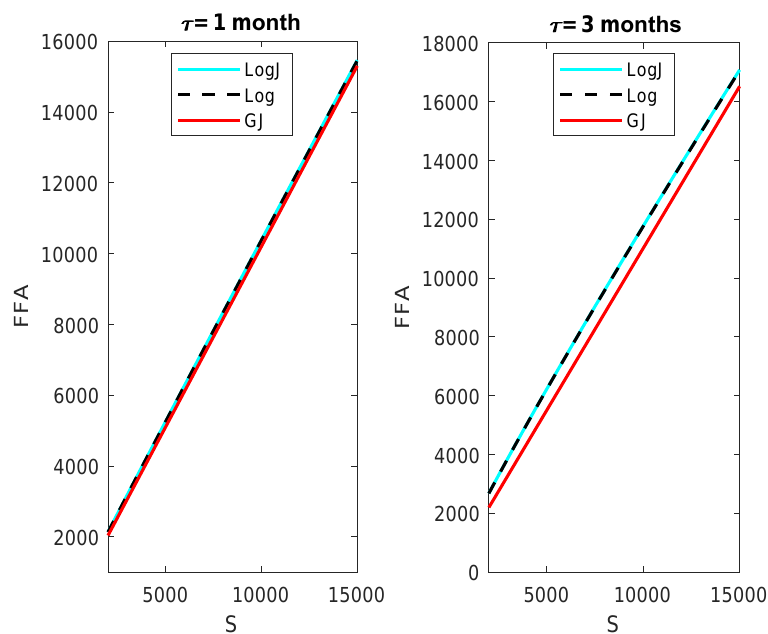
Figure 1. FFA prices with the LogJ, Log, and GJ models for maturities: 1 and 3 months. In order to analyze the impact of the mean reversion, we estimate the parameters when the spot freight rate follows the GJ model, see (6). We calibrate this model with the FFA prices of the LogJ model (our “market”), and we use the standard nonlinear least- squares solver in Matlab and the FFA price expression (8). The values of the estimated parameters are in Table 1 (third row). Then, we also price FFA contracts with the GJ model, S ∈ [2000, 10,000] and maturities: 1 and 3 months and plot them in Figure 1. As you